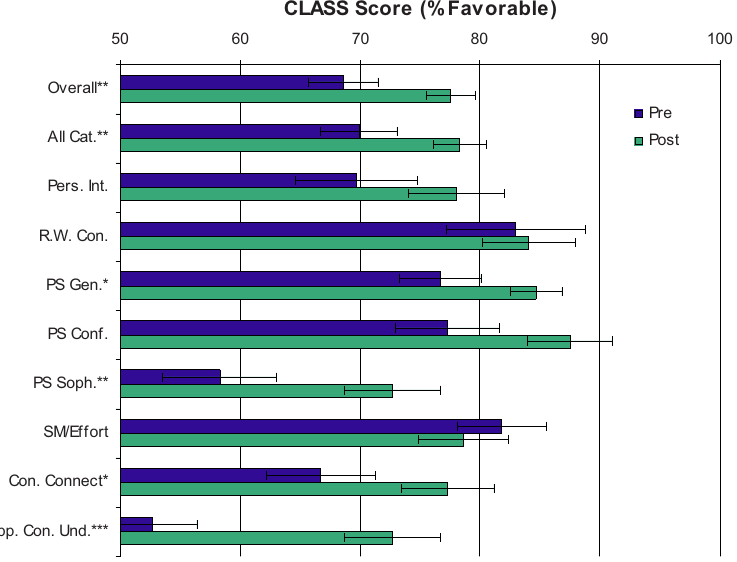
FIG. 1. (cid:1) Color online (cid:2) Average CLASS results from Fall 2007 (cid:1) N =22 (cid:2) . Error bars reflect the Standard Error of the Mean. (cid:1) p (cid:1) 0.05, (cid:1)(cid:1) p (cid:1) 0.01, (cid:1)(cid:1)(cid:1) p